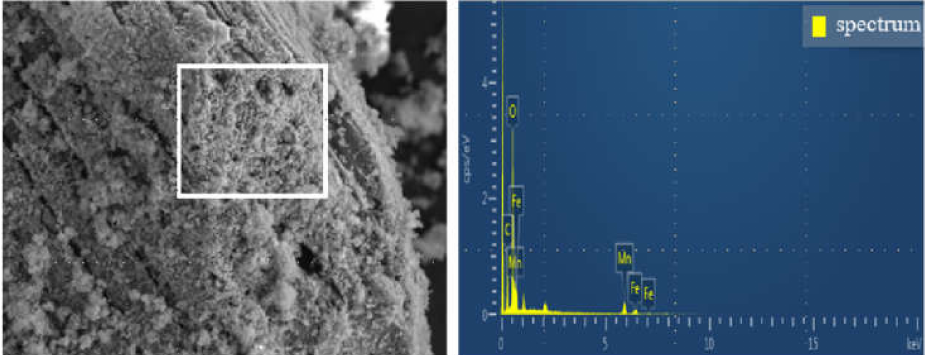
Figure 2. The EDS spectrum of